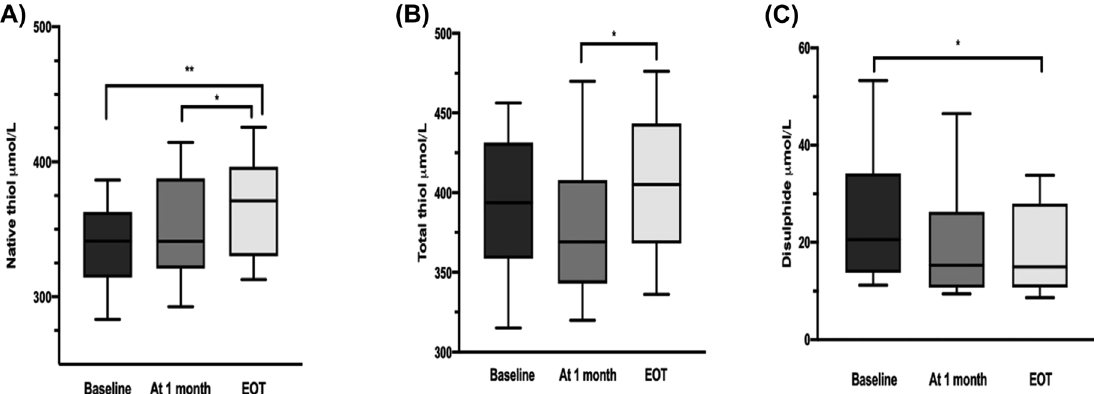
Figure 1: Comparison of the serum (A) native thiol, (B) total thiol and (C) disulphide levels in CHC cases at different time points. (A) *p=0.008 and **p=0.002, (B) *p=0.003, (C) *p=0.004. Data are presented with the Tukey box-and-whisker plot, where the middle line represents the median, and the box represents the IQR (the 25th and 75th percentiles).